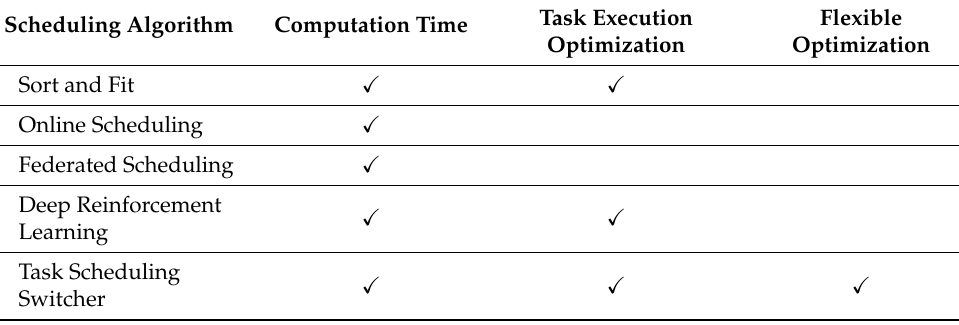
Table 2. Comparison between previous research conducted in real-time scheduling. Scheduling